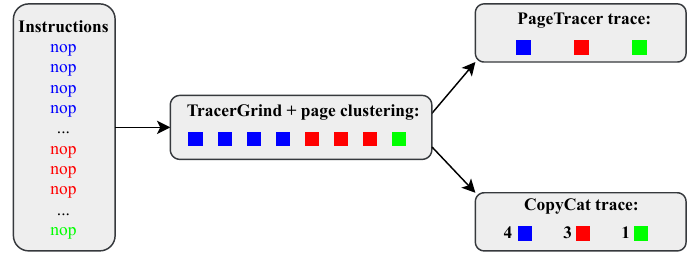
Figure 2: Leakage emulation using TracerGrind . Colors represent memory